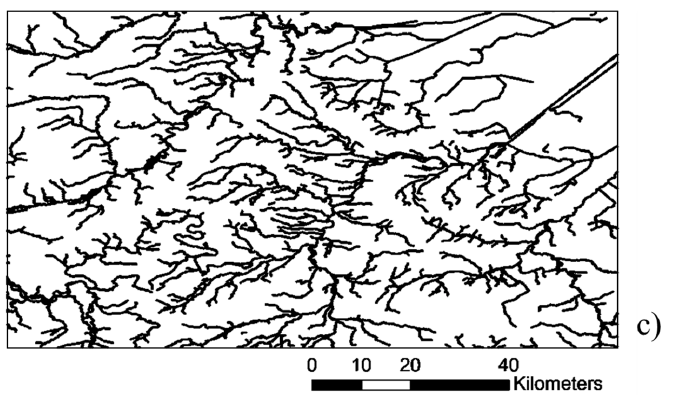
Figure 4. Study area drainage network: ( a ) OSM rivers and streams; ( b ) OSM rivers; and ( c ) Ordnance Survey reference drainage network.